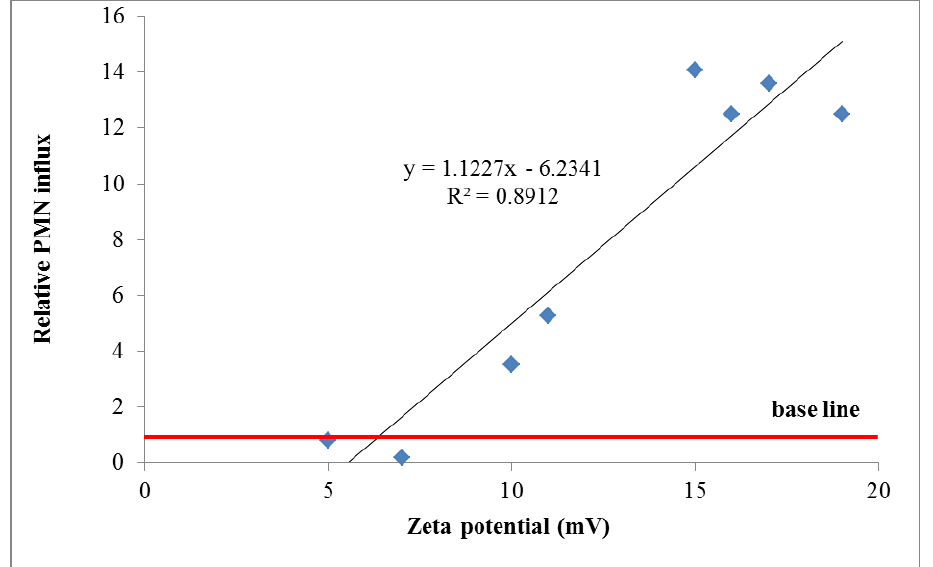
Figure 3. Weighting factor 3 ( w ) is depending on the zeta potential: The weighting PC,3 factor is proportional to the relative PMN influx and increases according to equation